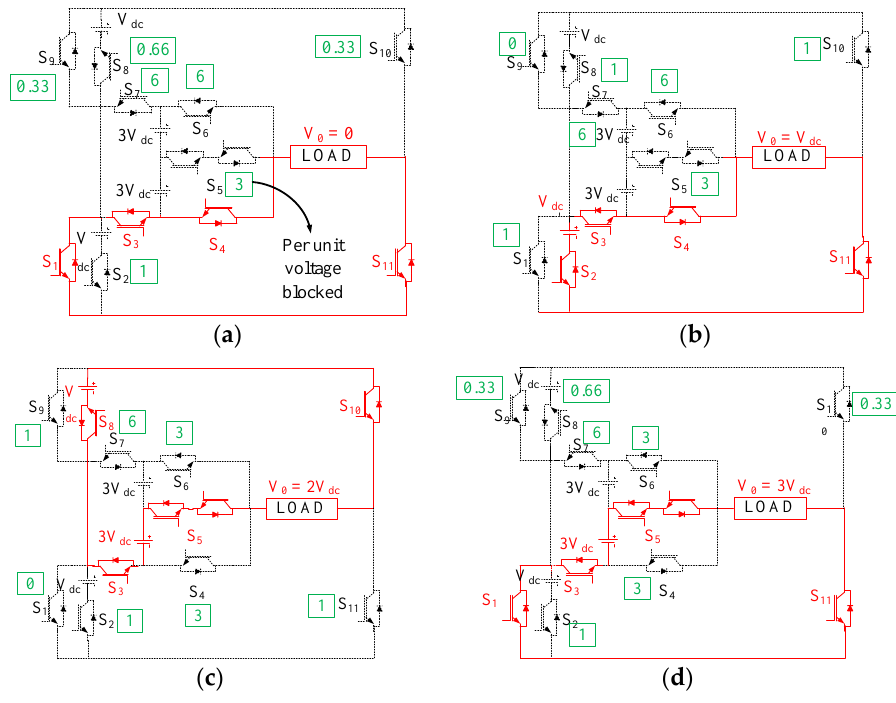
Figure 2. Positive conduction states (part 1). ( a ) State 0 ( b ) State 1 ( c ) State 2 ( d ) State 3.